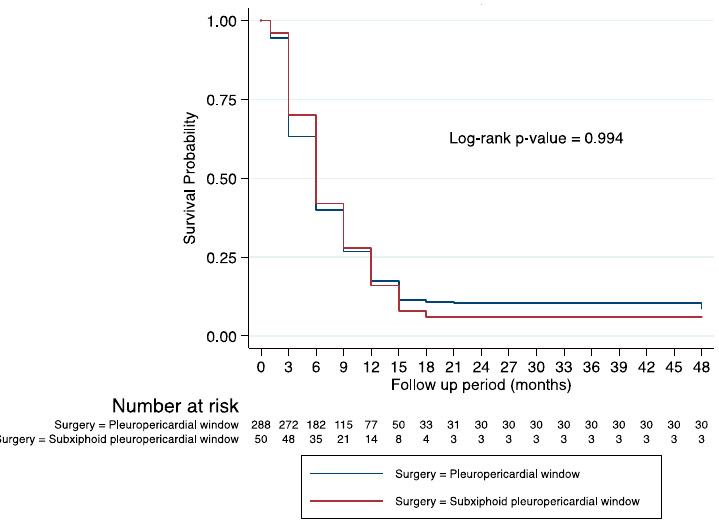
Figure 1. Kaplan–Meier Survival Curves by Surgery Approach.